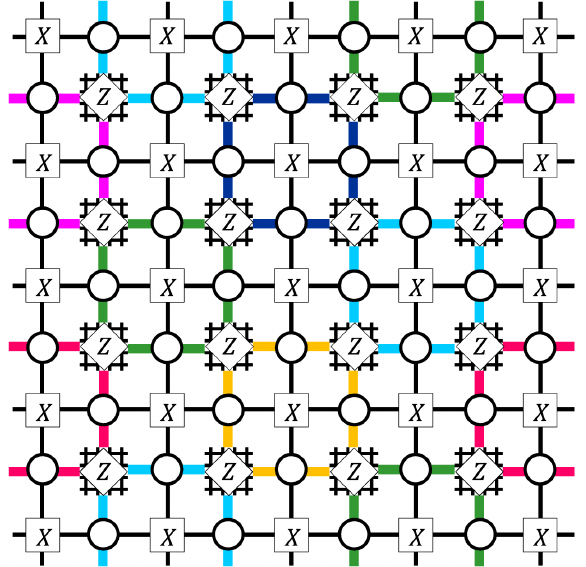
FIG. 5. The same lattice as Fig. 4, but with the mapping to the toric code superposed. The qubits in the toric code are indicated by open circles, and are on the links of the lattice. The mapping between the U ( 1 ) loops and the toric code star terms is indicated by the label Z , and the mapping between the Z 2 loops and the toric code plaquette terms is indicated by the label X